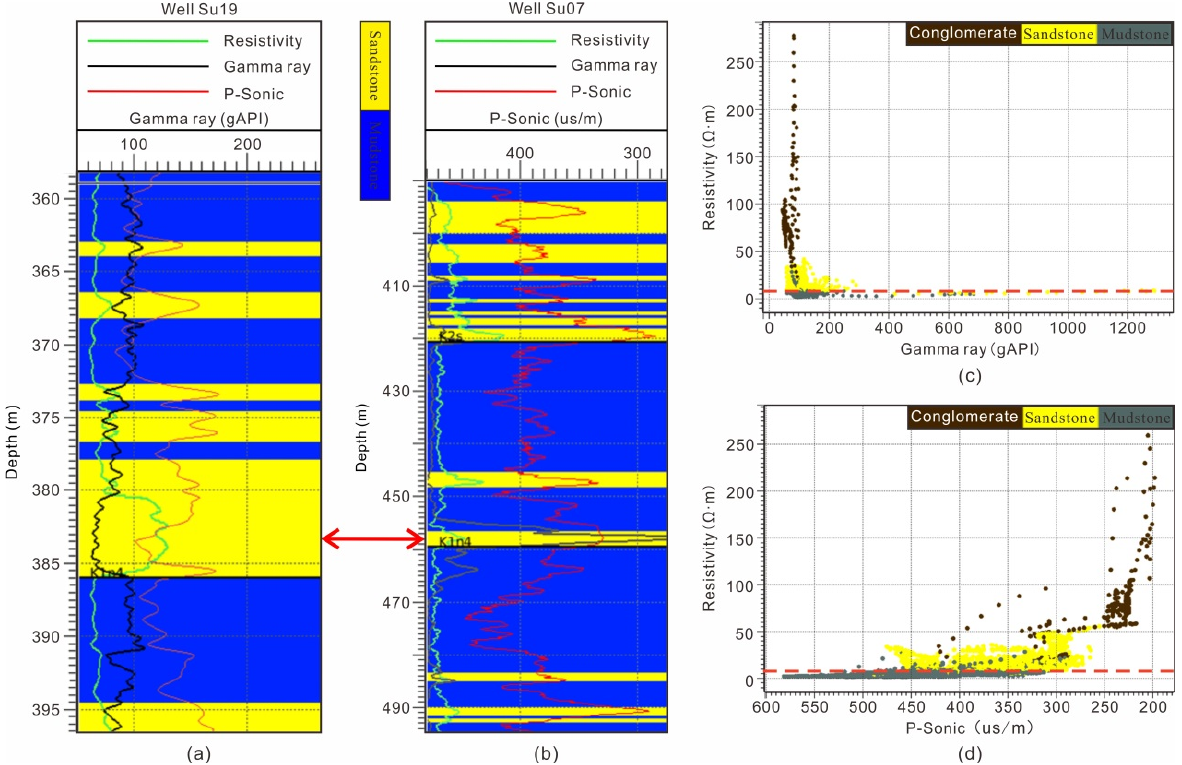
Figure 7. Petrophysical sensitivity analysis to drilling and logging data: ( a ) Drilling and logging data of well su19, ( b ) Drilling and logging data of well su07, ( c ) The intersection analysis between resistivity and gamma, ( d ) The intersection analysis between resistivity and P ‐ sonic.